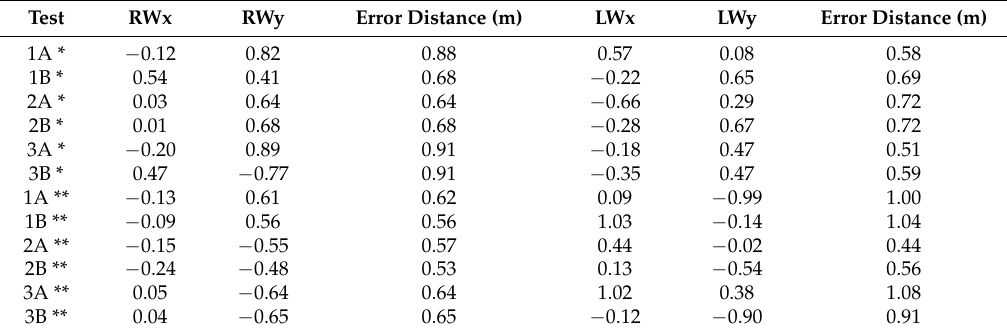
Table 3. Half court lap trajectory tracking results, comparing the IMU derived output with the known court markings. (Note: A denotes IMU set 1, and B denotes IMU set 2. * denotes clockwise travel. ** denotes anticlockwise travel).